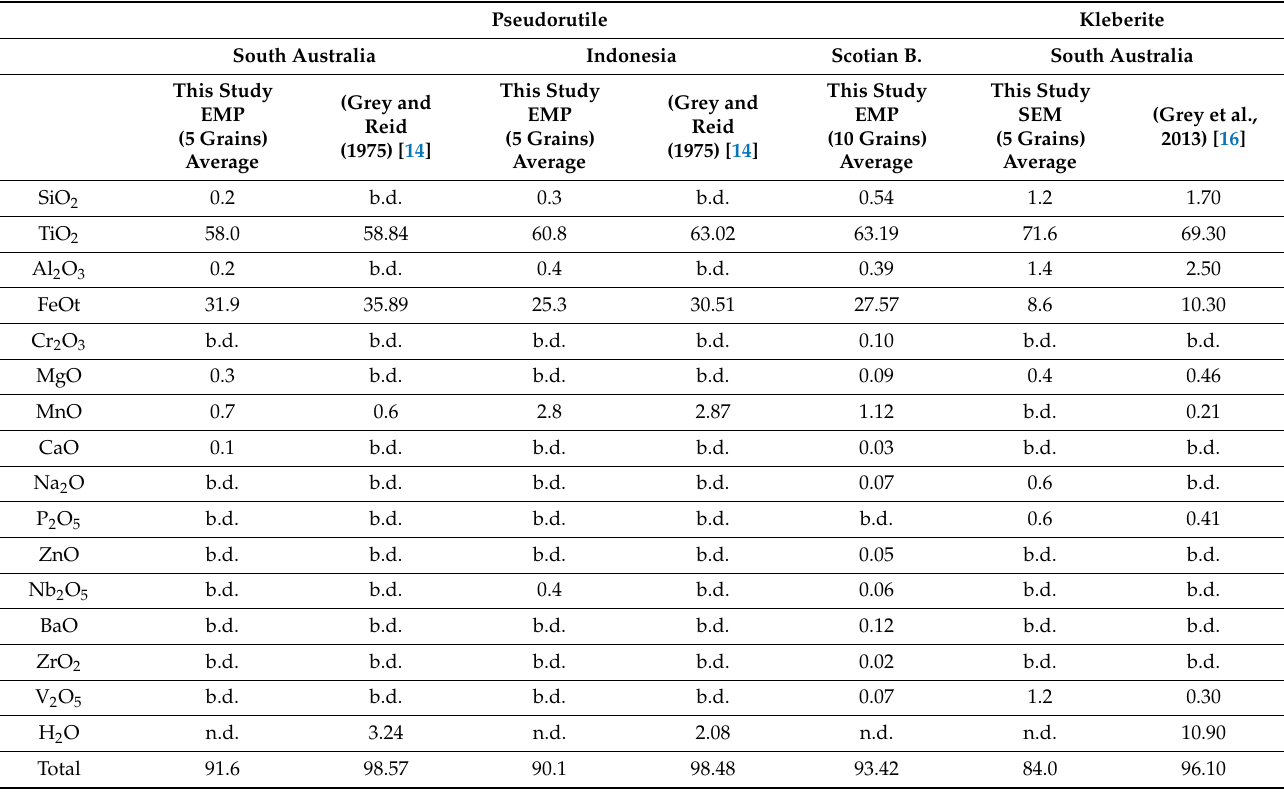
Table 1. Chemical analyses of pseudorutile and